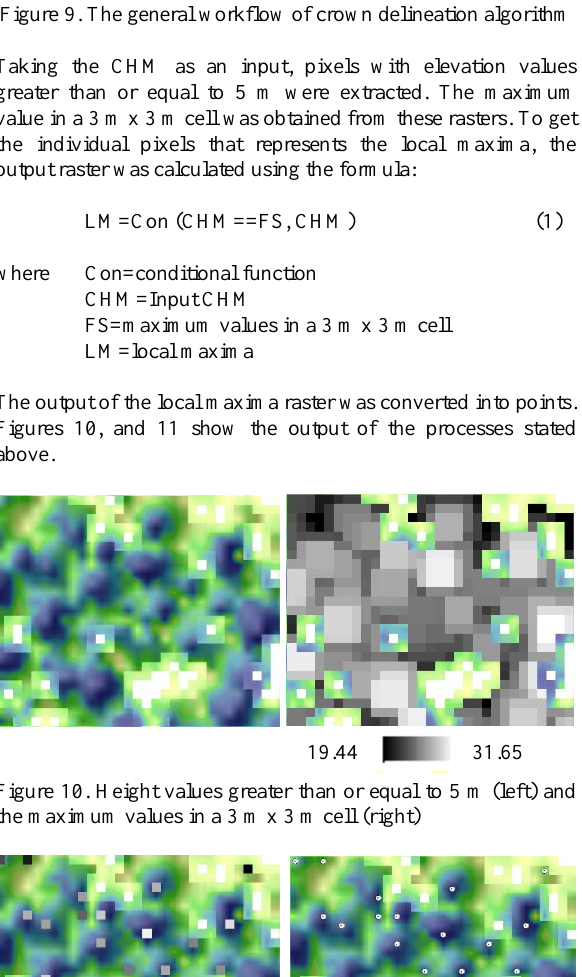
Figure 9. The general workflow of crown delineation algorithm